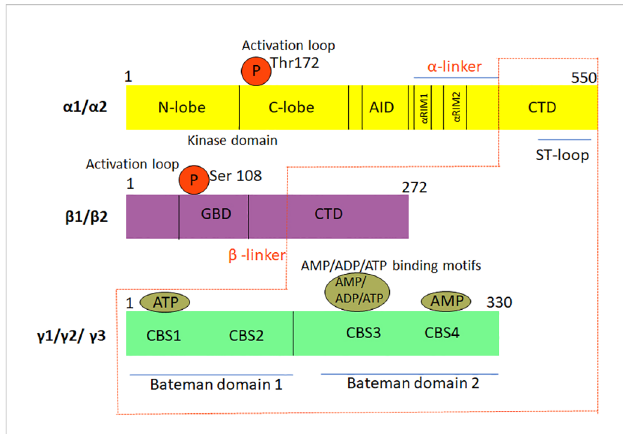
FIGURE 2 GraphicalrepresentationofthedomainstructureandisoformsofAMPK.The threesub-units,namely, abg ,whichconstitutetheheterotrimericcomplex structureofAMPKhavedifferentisoforms.Whilethe a and b sub-unitshave twoisoformseach,the g sub-unithasthreeisoforms.Thr,threonine;Ser, Serine;AID,Autoinhibitorydomain;ST-loop,Stemloop;CTD,C-terminal domain; a RIM1/2, a -subunitmotifs; a / b linker,regulatorylinkerregion;GBD, GTPaseproteinbindingdomain;CBS1domain,Cystathioninebetasynthase1 domain;CBS2domain,Cystathioninebetasynthase2domain;CBS3domain, Cystathioninebetasynthase3domain;CBS4domain,Cystathioninebeta synthase4domainAMP,Adenosinemonophosphate;ADP,Adenosine